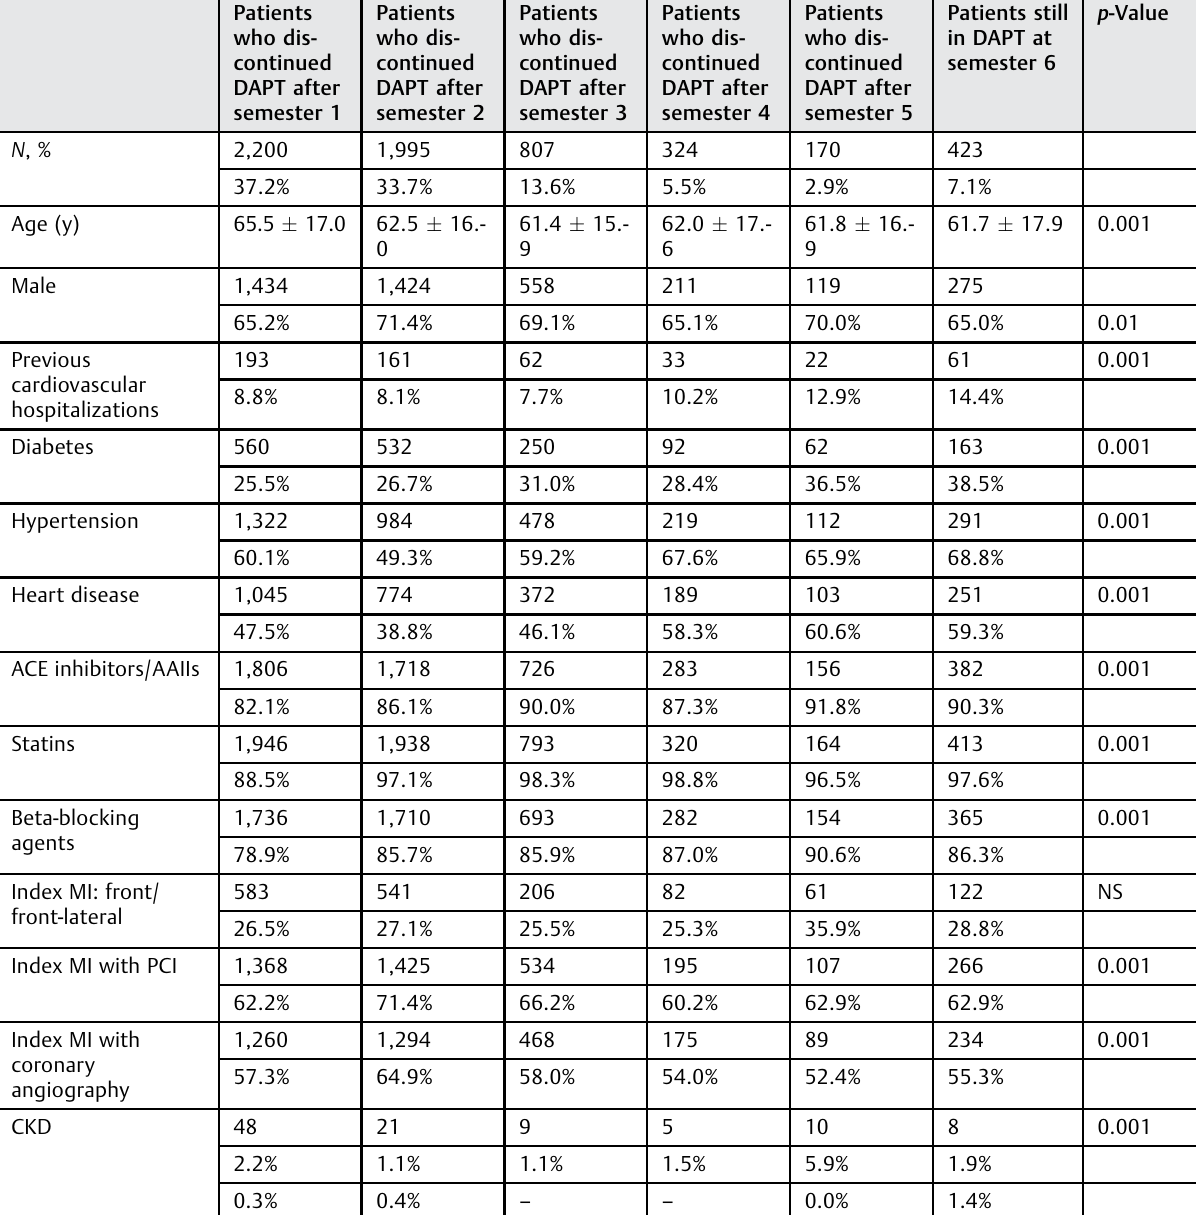
Table 3 Demographic and clinical characteristics of patients by semester of DAPT interruption Patients who